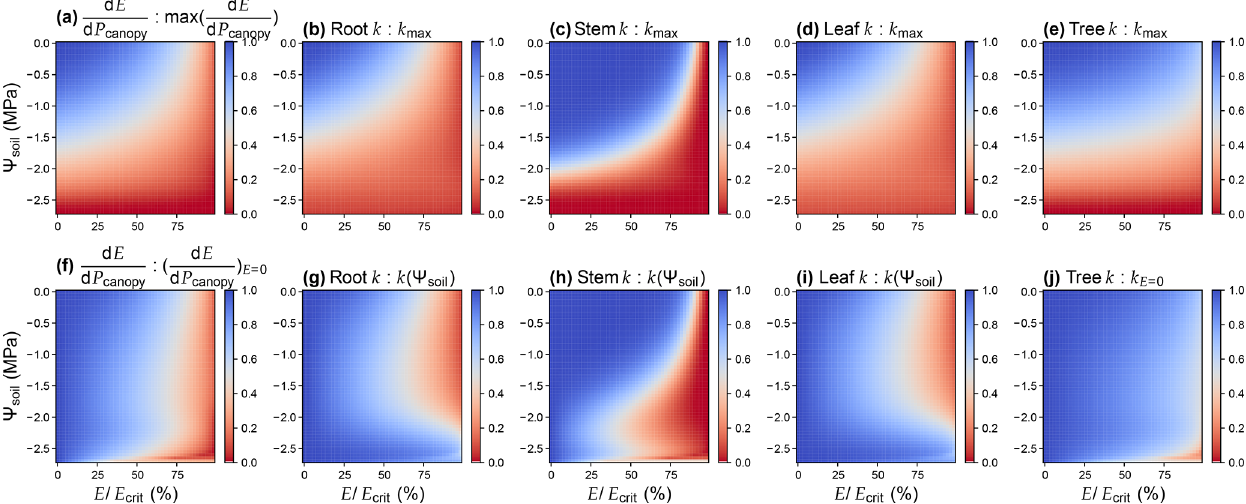
Figure 3. Comparison of different risk measures of stomatal opening. (a)–(e) Values are relative to the maximum when soil water potential is 0 and the transpiration rate is 0. (f)–(j) Values are relative to the maximal when the transpiration rate is 0 at the given soil water potential. The simulation is done assuming there is no drought legacy effect from previous xylem embolism. For the simulation, the plant has a root:stem:leaf resistance ratio of 2:1:1; root and stem height change are 1 and 10m, respectively; VCs are represented using a Weibull function; Weibull B and C are 1.879MPa and 2.396 for root, 2.238MPa and 9.380 for stem, and 1.897MPa and 2.203 for leaf (data from Wang et al., 2019). See Table 1 for the list of